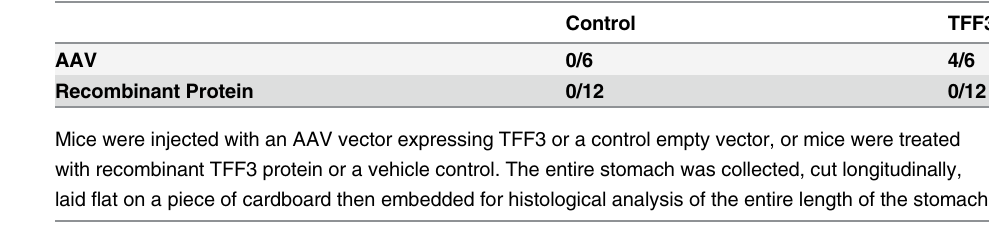
Table 1. Presence of mucinous metaplasia.